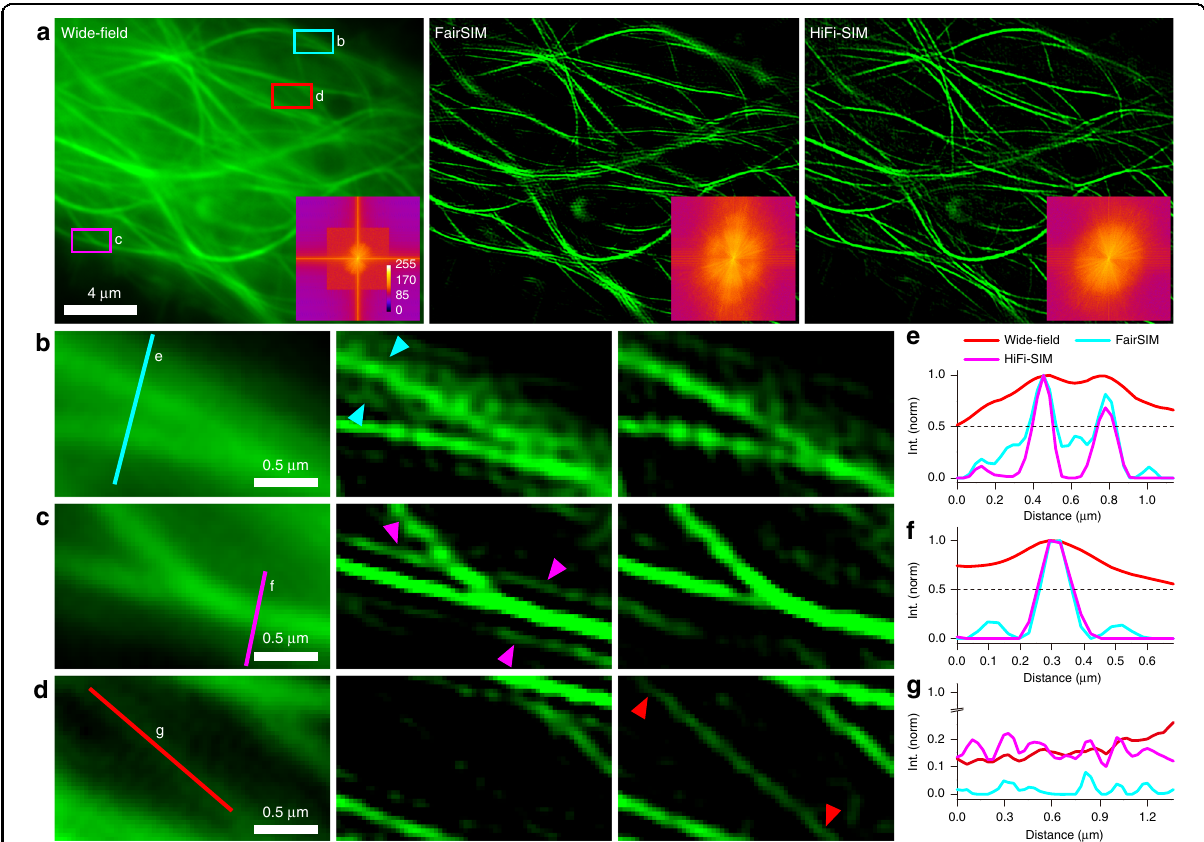
Fig. 5 Performance of HiFi-SIM on reconstructing raw data with low modulation depth and strong background. a Equivalent wide- fi eld image of microtubules in live U2OS cells with strong background fl uorescence is shown in the left, and the SR images reconstructed using fairSIM and HiFi-SIM. Lower-right corner shows corresponding reconstructed spectrum. b – d Magni fi ed images of the red-box, cyan-box, and magenta-box regions in a . e – g Intensity pro fi les along the red, cyan, and magenta lines in b – d ,